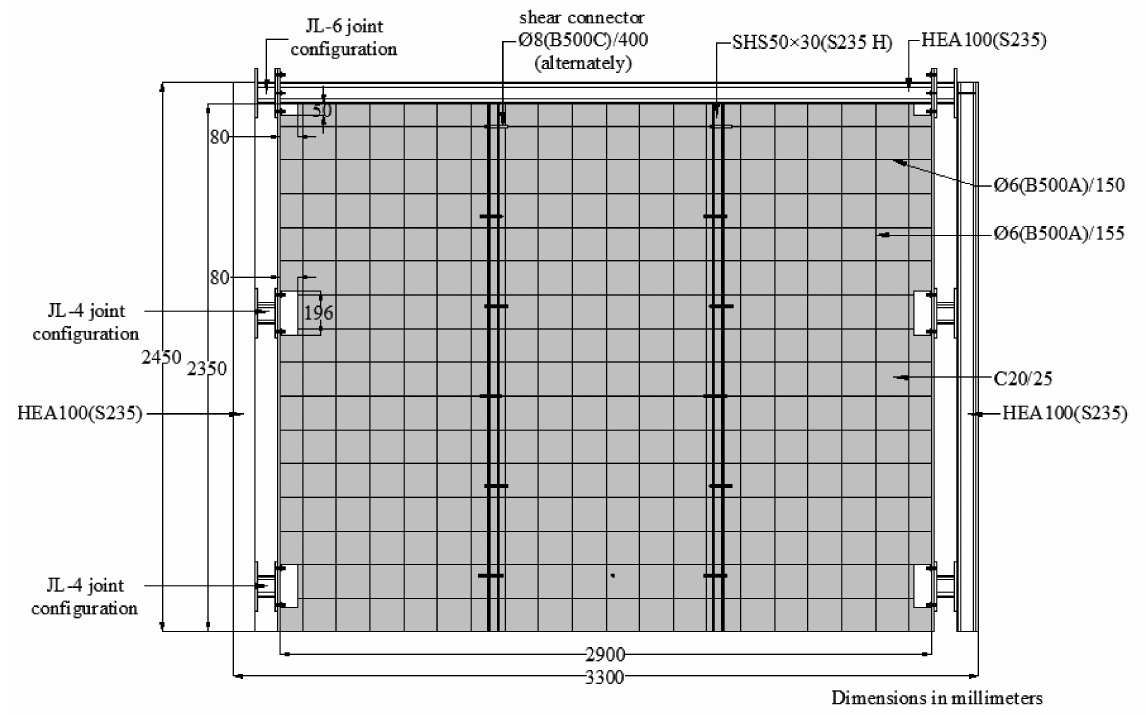
Figure 19. Front schematic view of the PCSP-ISF model configuration [19,20].